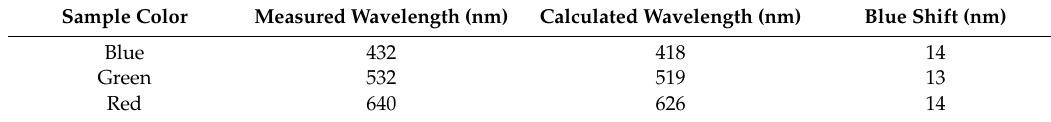
Table 3. The measured and calculated wavelengths of samples with various